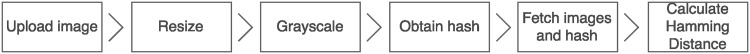
Typical hash-based algorithms flow diagram.